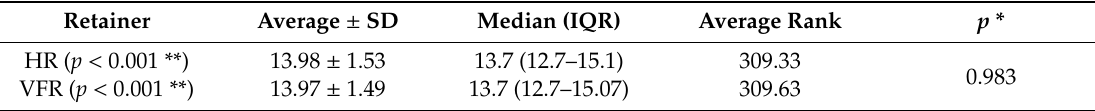
Table 2. Comparison of patients’ age according to the type of retainer.